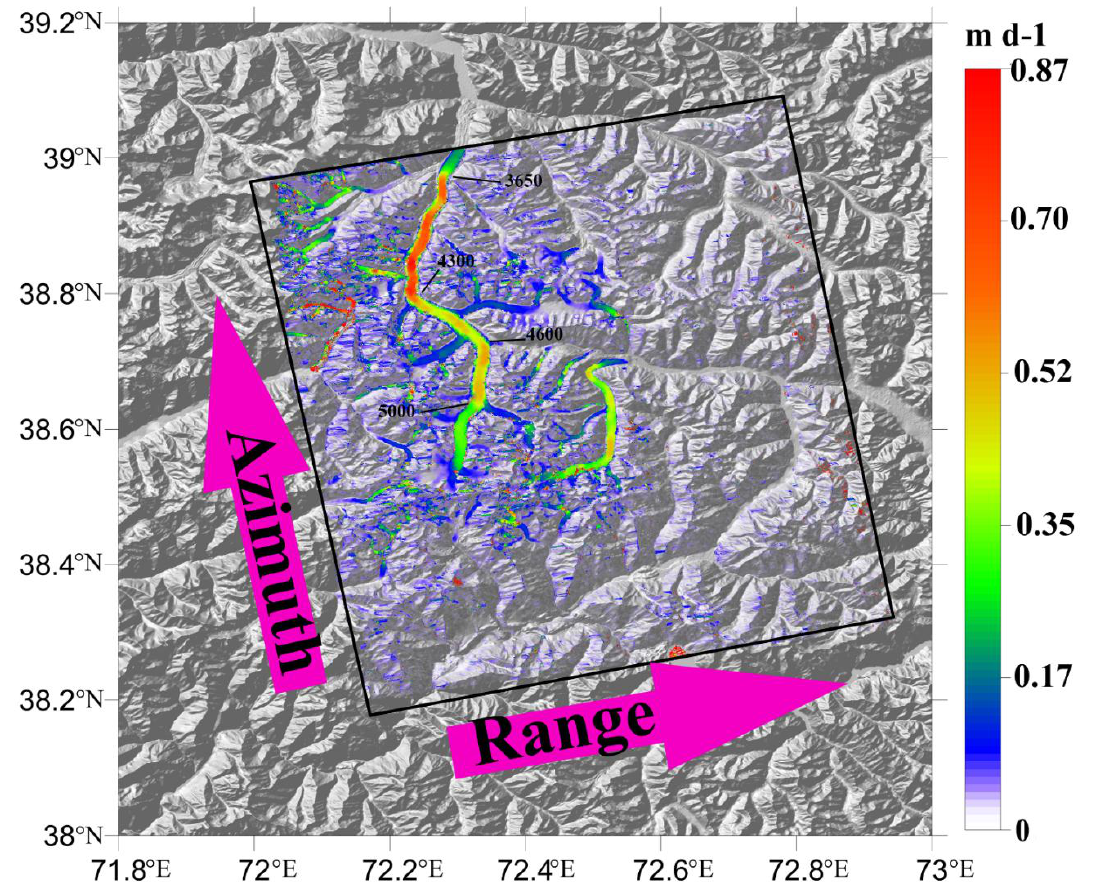
Figure 4. Geocoded glacier surface flow velocity field superimposed on a shaded-relief map of the DEM. The number of 3650, 4300, 4600 and 5000 indicates the elevation of corresponding